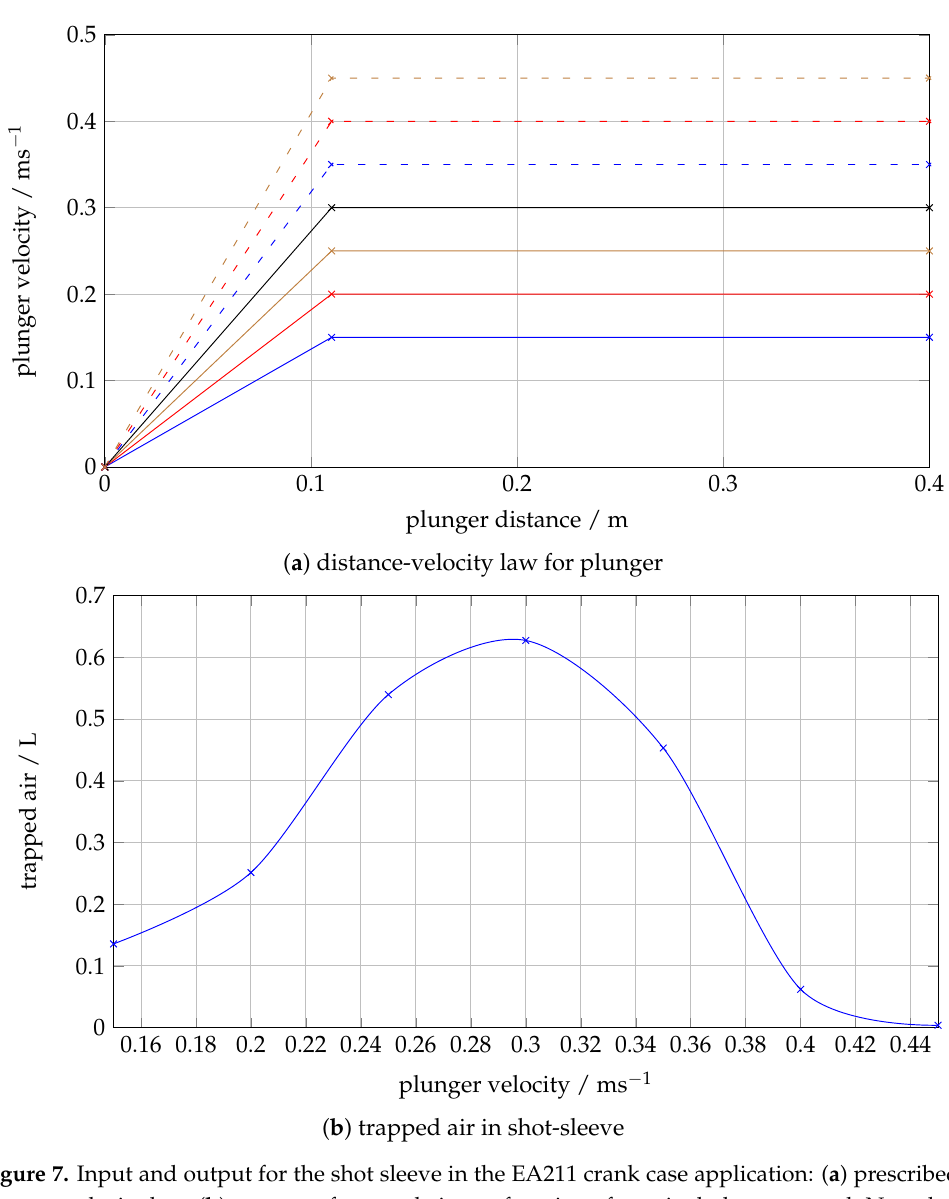
Figure 7. Input and output for the shot sleeve in the EA211 crank case application: ( a ) prescribed plunger velocity law; ( b ) amount of trapped air as a function of terminal plunger speed. Note that initially there is 4.7 L of air in the chamber, which has a volume of 13.5